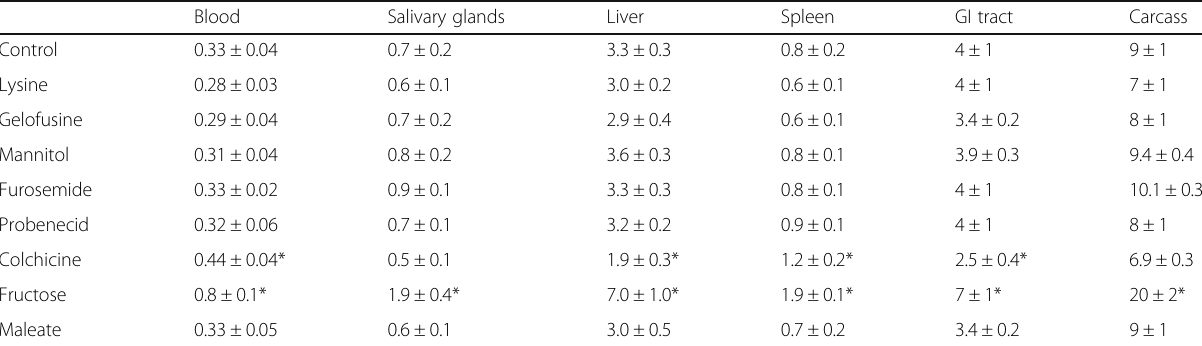
Table 2 Biodistribution of [ 99m Tc]Tc(CO) 3 -G3 in NMRI mice 4 h p.i. alone (control) or after administration of compounds Blood Salivary glands